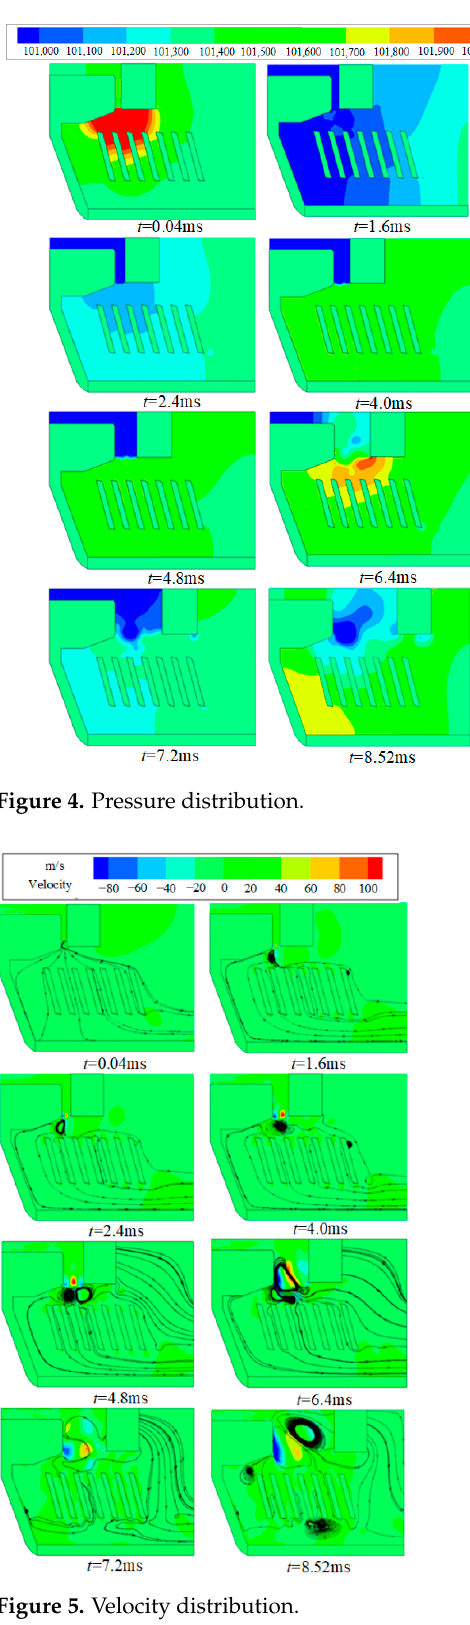
Figure 5. Velocity Figure 5. Velocity distribution.